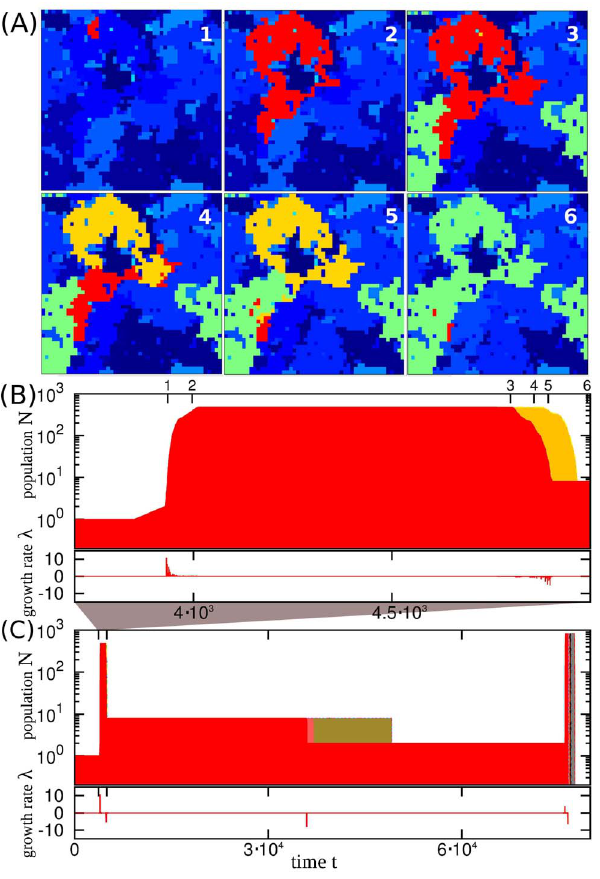
Figure 1. Example of the time evolution in the steady state. For a system with size L ~ 50 , link penalty E ~ 0 : 4 and mutation rate a N ~ 5 | 10 { 6 . (A) Snapshots of the system at the times marked in top of panel B. (B) Time evolution of the population size, N , of the species marked in red in panel A. The population size, N , of its offspring species is shown in yellow. Below the panel is depicted the growth rate, l , defined through Eq. (1). (C) Time evolution of the population size of the same species and its offspring species as in panel B on a longer time scale. There are many more offspring species, but ultimately the whole lineage goes